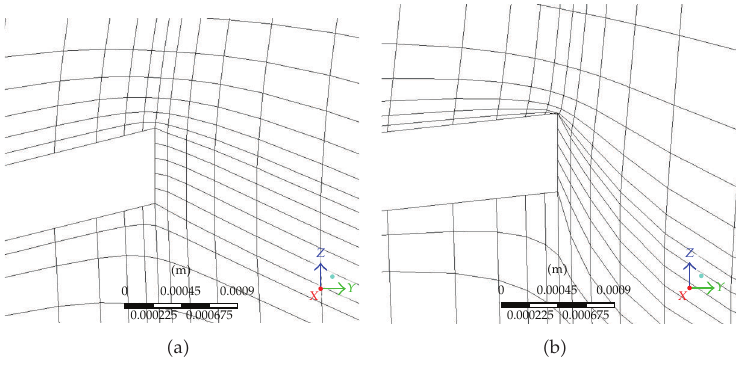
Figure 3: Di ff erent coe ffi cients for mesh sti ff